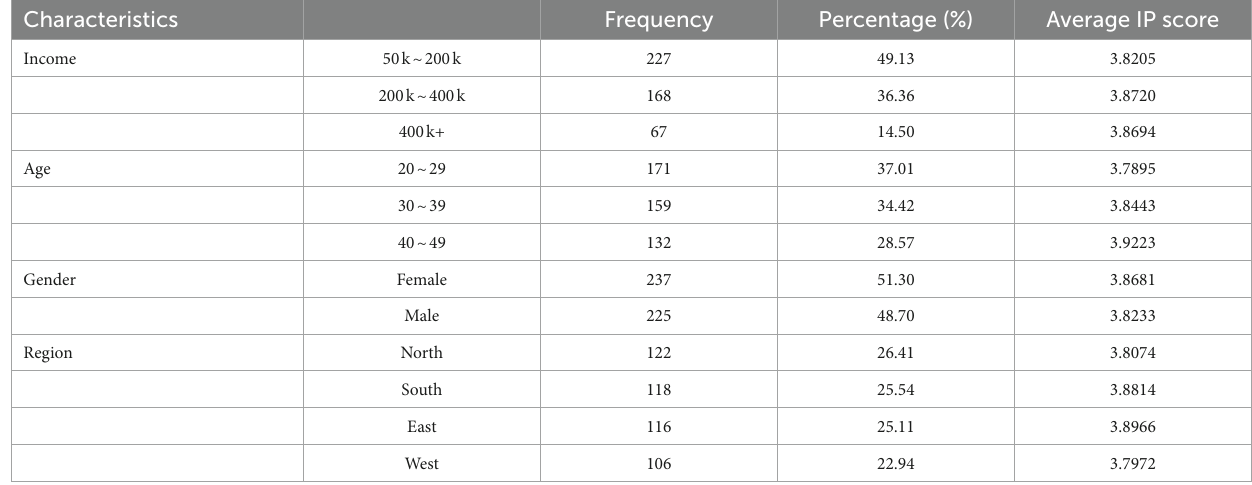
TABLE 1 Demographic profiles of the respondents ( n =